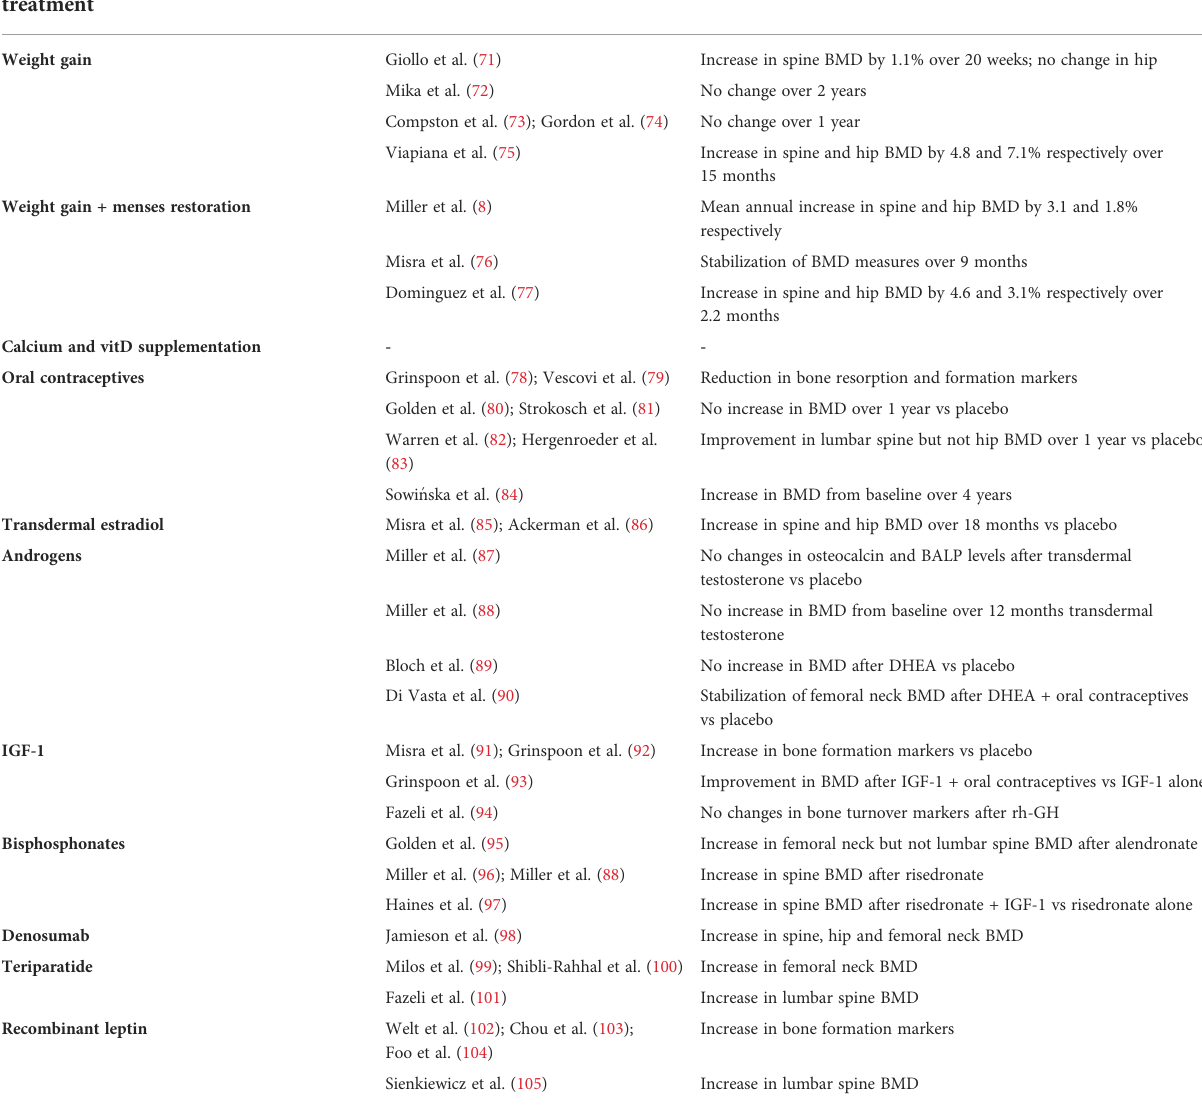
TABLE 2 Summary of evidence of lifestyle change and pharmacologic